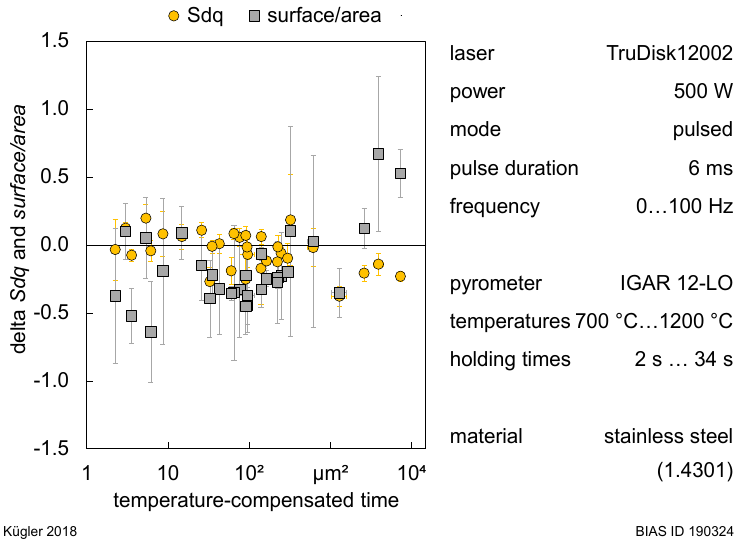
Figure 4. Roughness value Sdq and topography factor surface/area of laser-heated 1.4301 sheets.